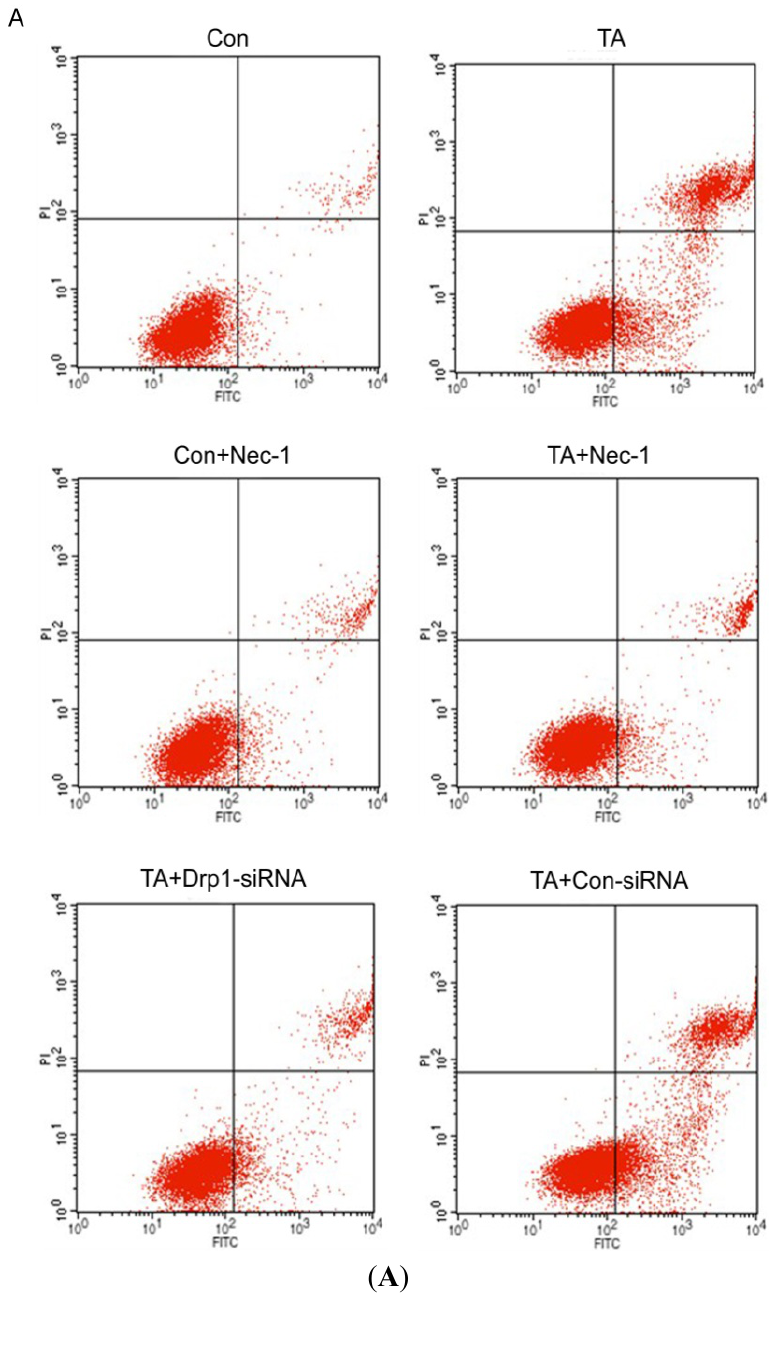
Figure 2. Effect of Nec-1 and Drp1 -siRNA on cell death of NRK-52e cells induced by ischemia injury determined by flow cytometry using Annexin-FITC/PI staining. ( A ) Flow cytometry displayed the effect of Nec-1 on cell death of NRK-52E cells induced by ischemia injury with TNF- α stimulation and ATP depletion; ( B ) Quantification of cell death percentages of the NRK-52E cells with different treatments. Note: * p < 0.01, vs. Con group; # p < 0.05, vs. TA